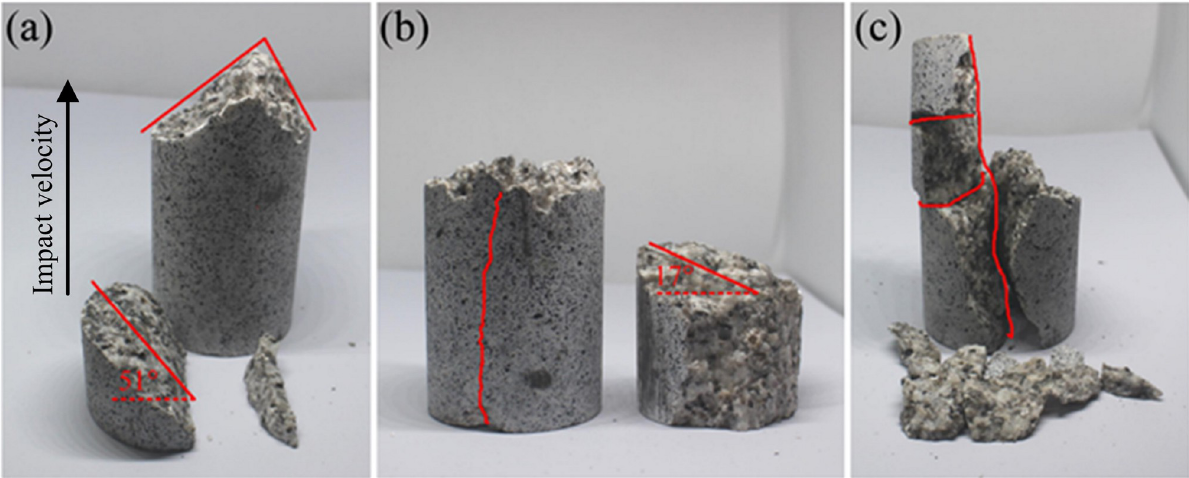
Fig 3. Failure patterns of rock specimens subjected to different impact velocities. (a) 20.0 m/s, (b) 25.0 m/s, and (c) 30.0 m/s.